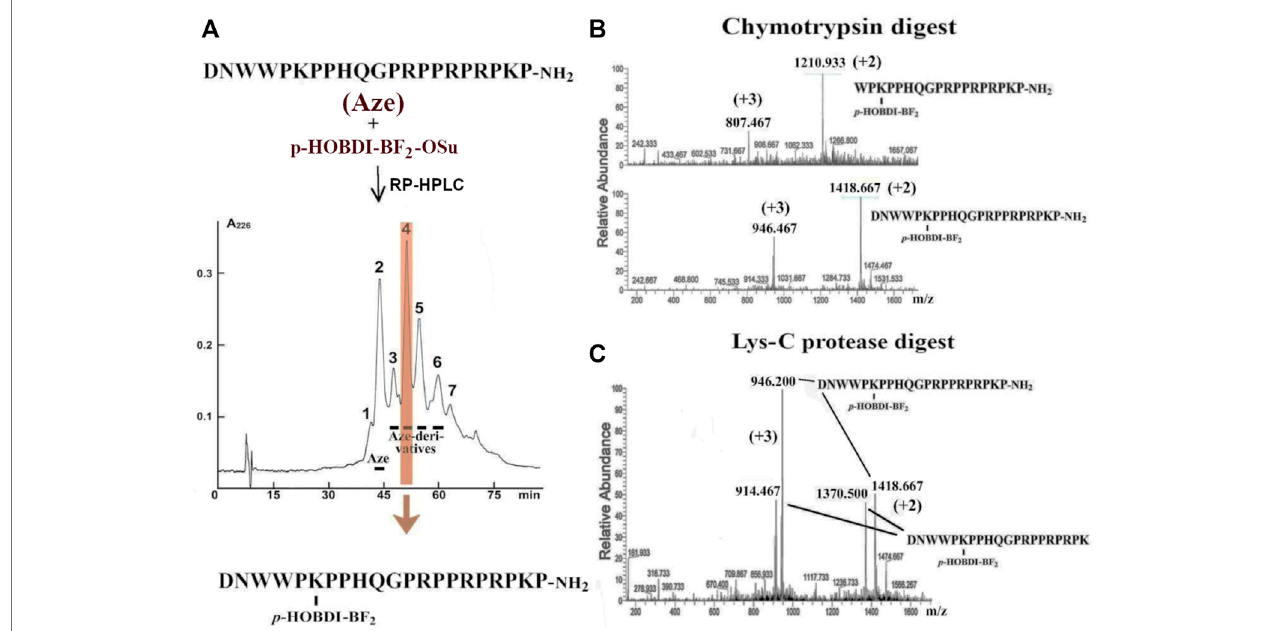
FIGURE3|(A) PreparationofAzederivatives.Azewasreactedwith p -HOBDI-BF 2 -OSuandtheobtainedderivativeswereseparatedbyreversed-phase HPLCon a Jupiter C 18 column (10 × 250 mm) in a linear gradient of acetonitrile (15 – 30% in 75 min). Peak 4 (shaded in orange) was found as the best puri fi ed individual mono- derivative (HOBDI-BF 2 – Aze) with localization of the photolabel at the ε -amino group of Lys6, as established by chromato-mass spectrometry of its fragments after digestionwithchymotrypsinorLys-Cproteinase. (B) Chromato-mass spectrometryanalysisofpeak4digestedwithchymotrypsinrevealedthefragmentswiththe measured m/z values 1,418.667 (+2) and 1,210.933 (+2) or 946.467 (+3) and 807.467 (+3) Da. They correspond to the masses of the non-digested HOBDI-BF 2 – Aze and the fragment Aze (4 – 21) with p -HOBDI-BF 2 label. (C) Chromato-mass spectrometry analysis of peak 4 digested with Lys-C protease. Identi fi ed m/z